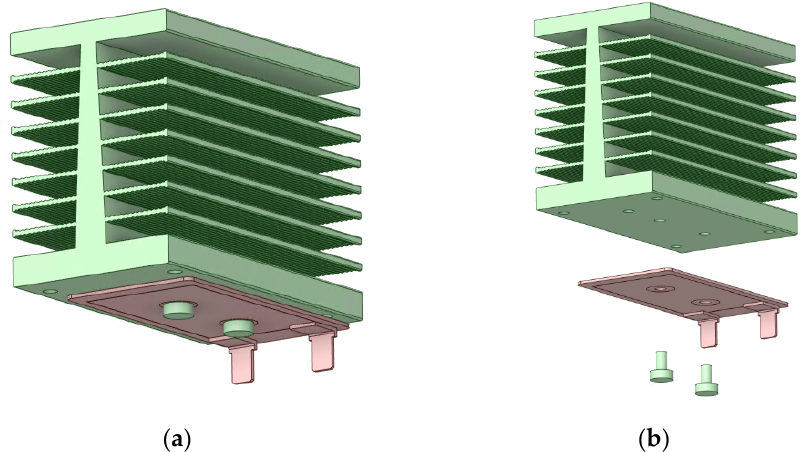
Figure 8. ( a ) Simulated geometry; ( b ) Exploded view of the simulated geometry.